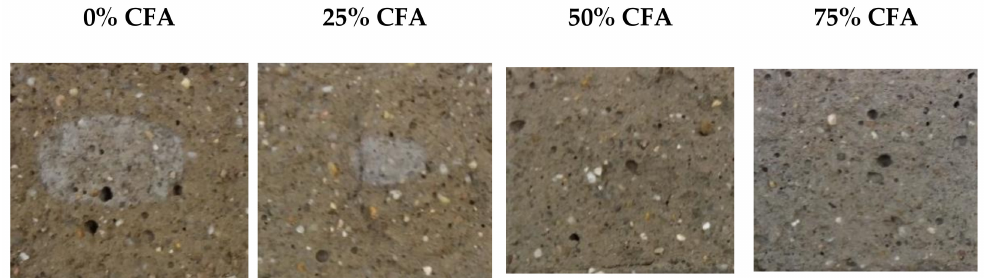
Figure 15. Internal appearance of samples with